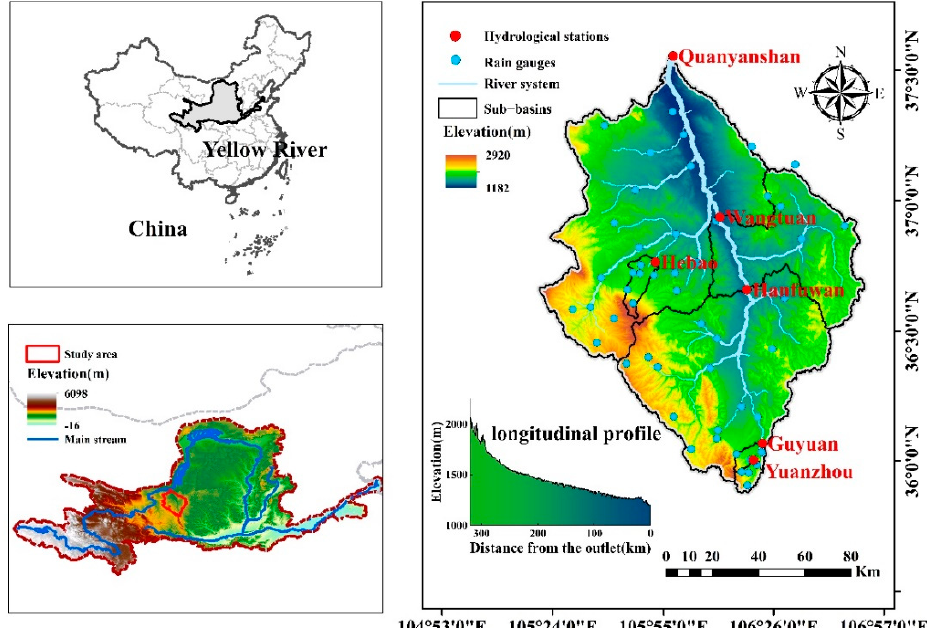
Figure 1. The geographical location of the studied basin, hydrological stations, and rain gauges.